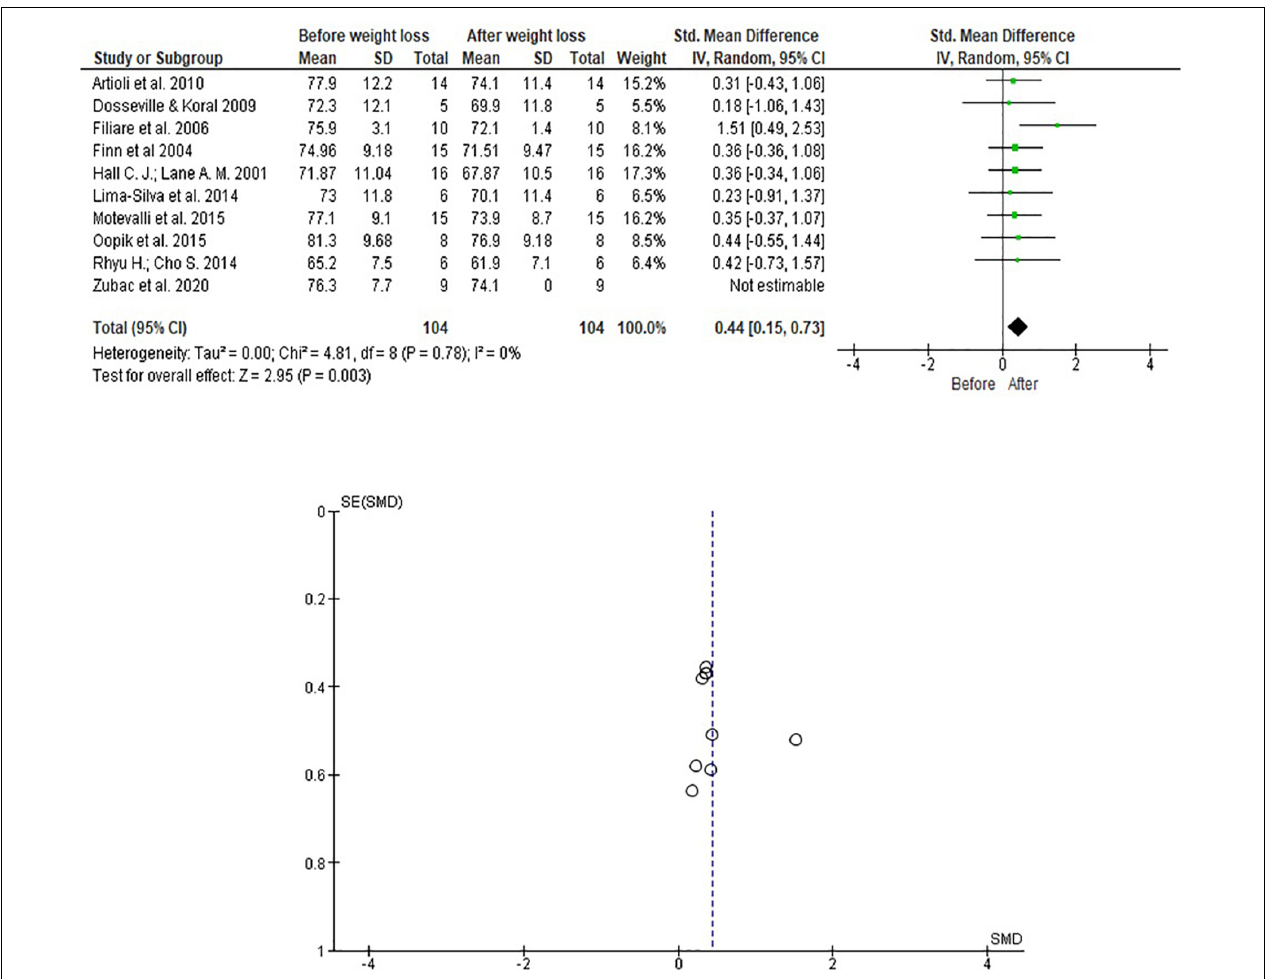
FIGURE 2 | Meta-analysis considering RWL studies with ∼ 3% of Olympic combat athletes’ body